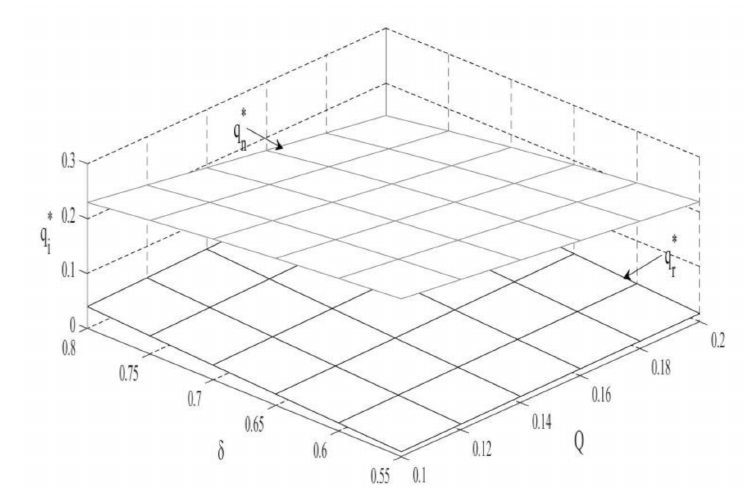
Figure 2. The impact of Q and δ on the sales